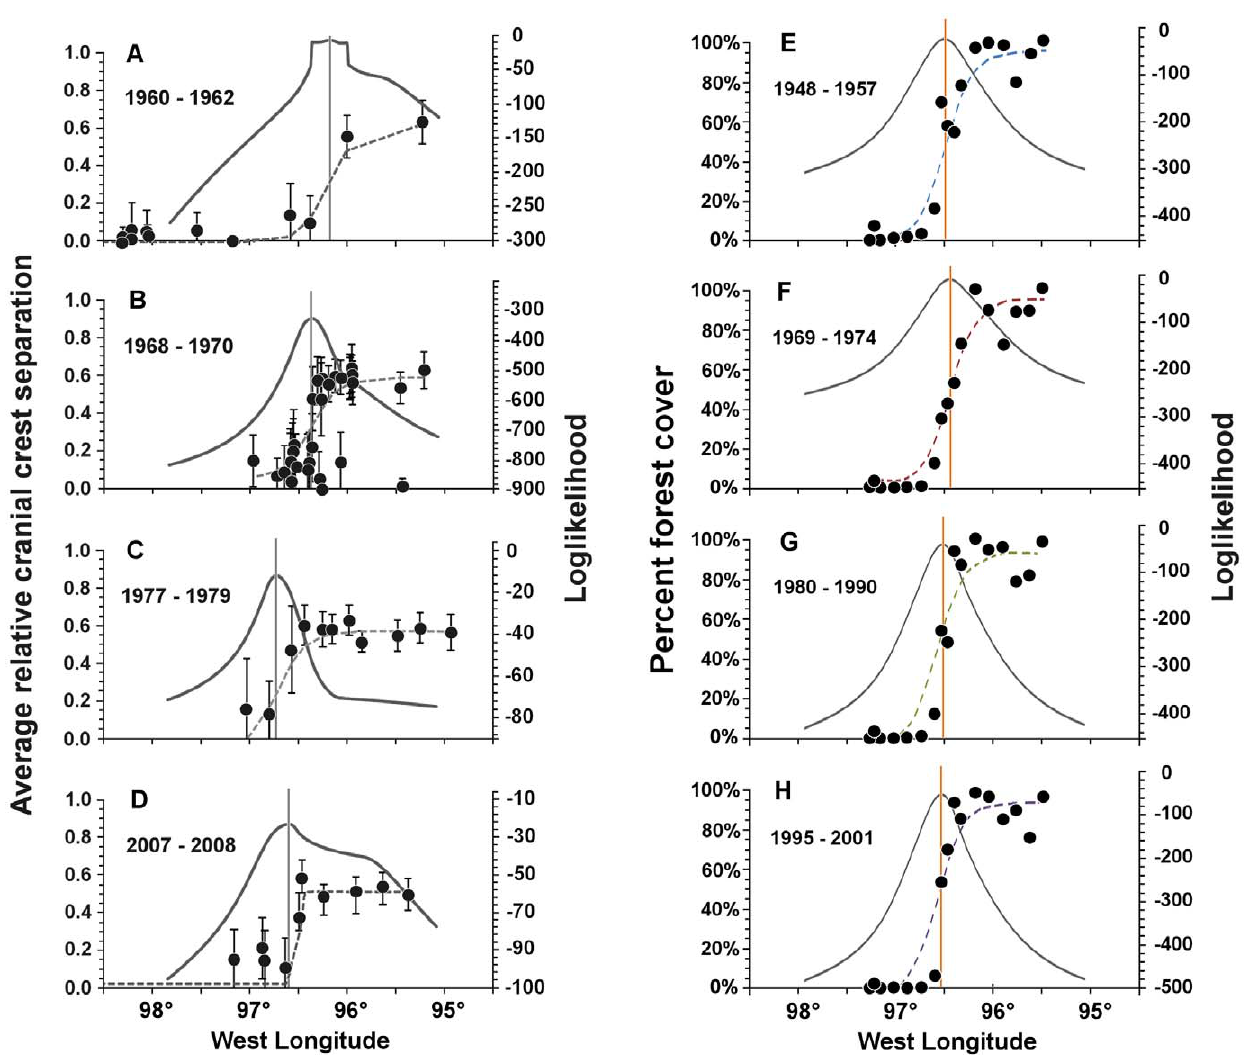
Figure 4. Position and shape of clines in southeastern Manitoba in (A–D) cranial crest separation in samples of Canadian Toad, Anaxyrushemiophrys , American Toad, A . americanus , and their hybrids at different times between1960 and 2008, and (E–F) the forest-prairie habitat transition at different times between 1948 and 2001. Dashed lines are the best fit shapes of clines. Solid lines depict likelihood profiles. The vertical line represents the position of the cline